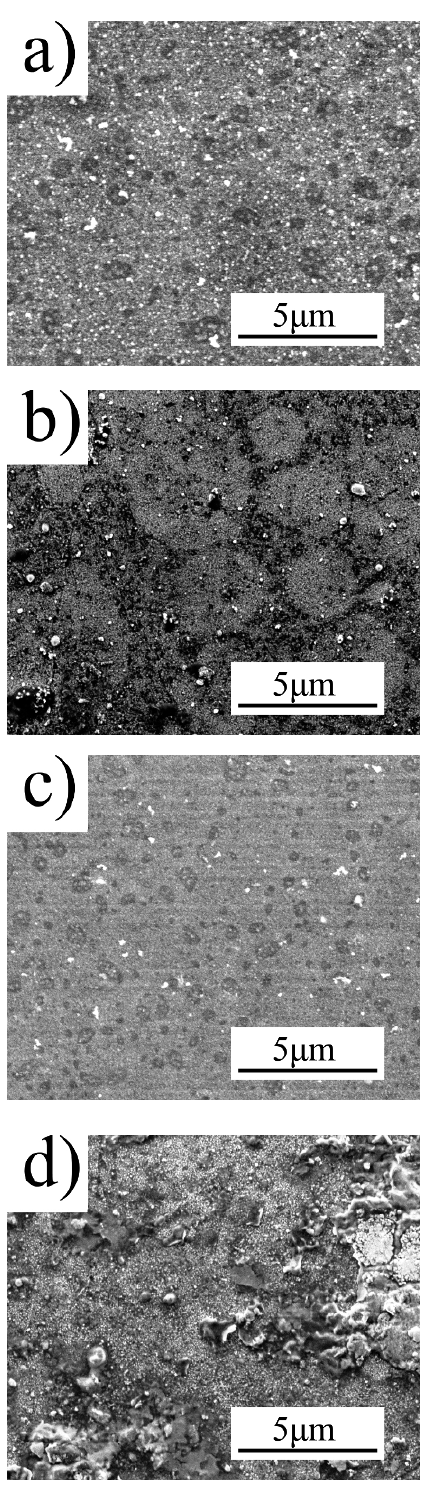
Figure 1. SEM micrographs of Cu Se layers on PA films formed by x the sorption-diffusion method with different duration of seleniumization. Duration of seleniumization, h: a) – 0.17, b) – 1.0, c) – 2.5, d) –